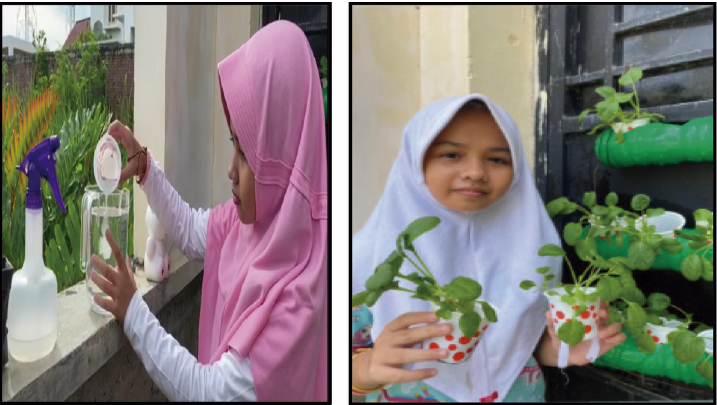
Figure 8. Students doing a hydroponic